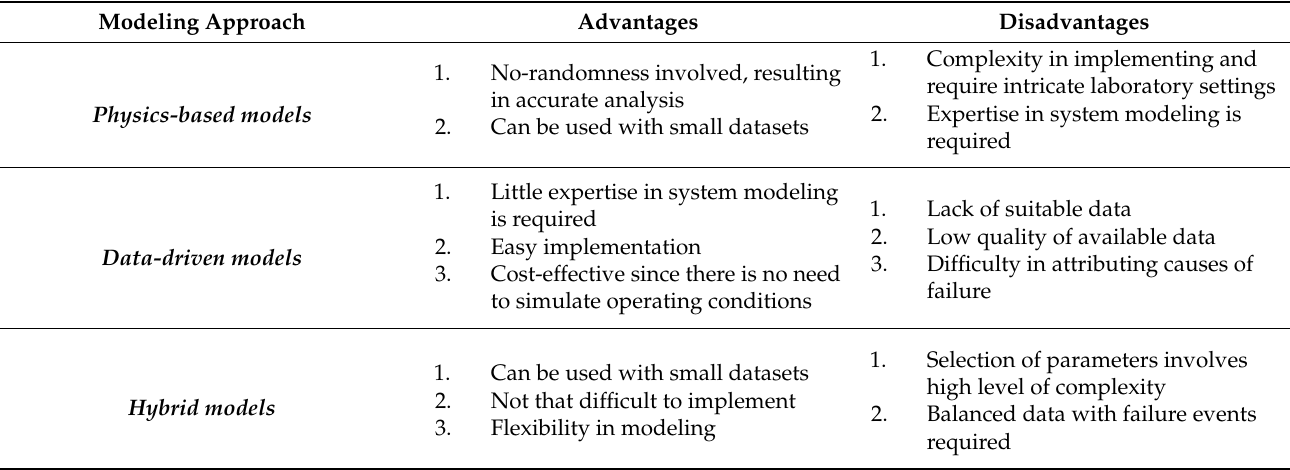
Table 1. Advantages and disadvantages of prognostics modeling